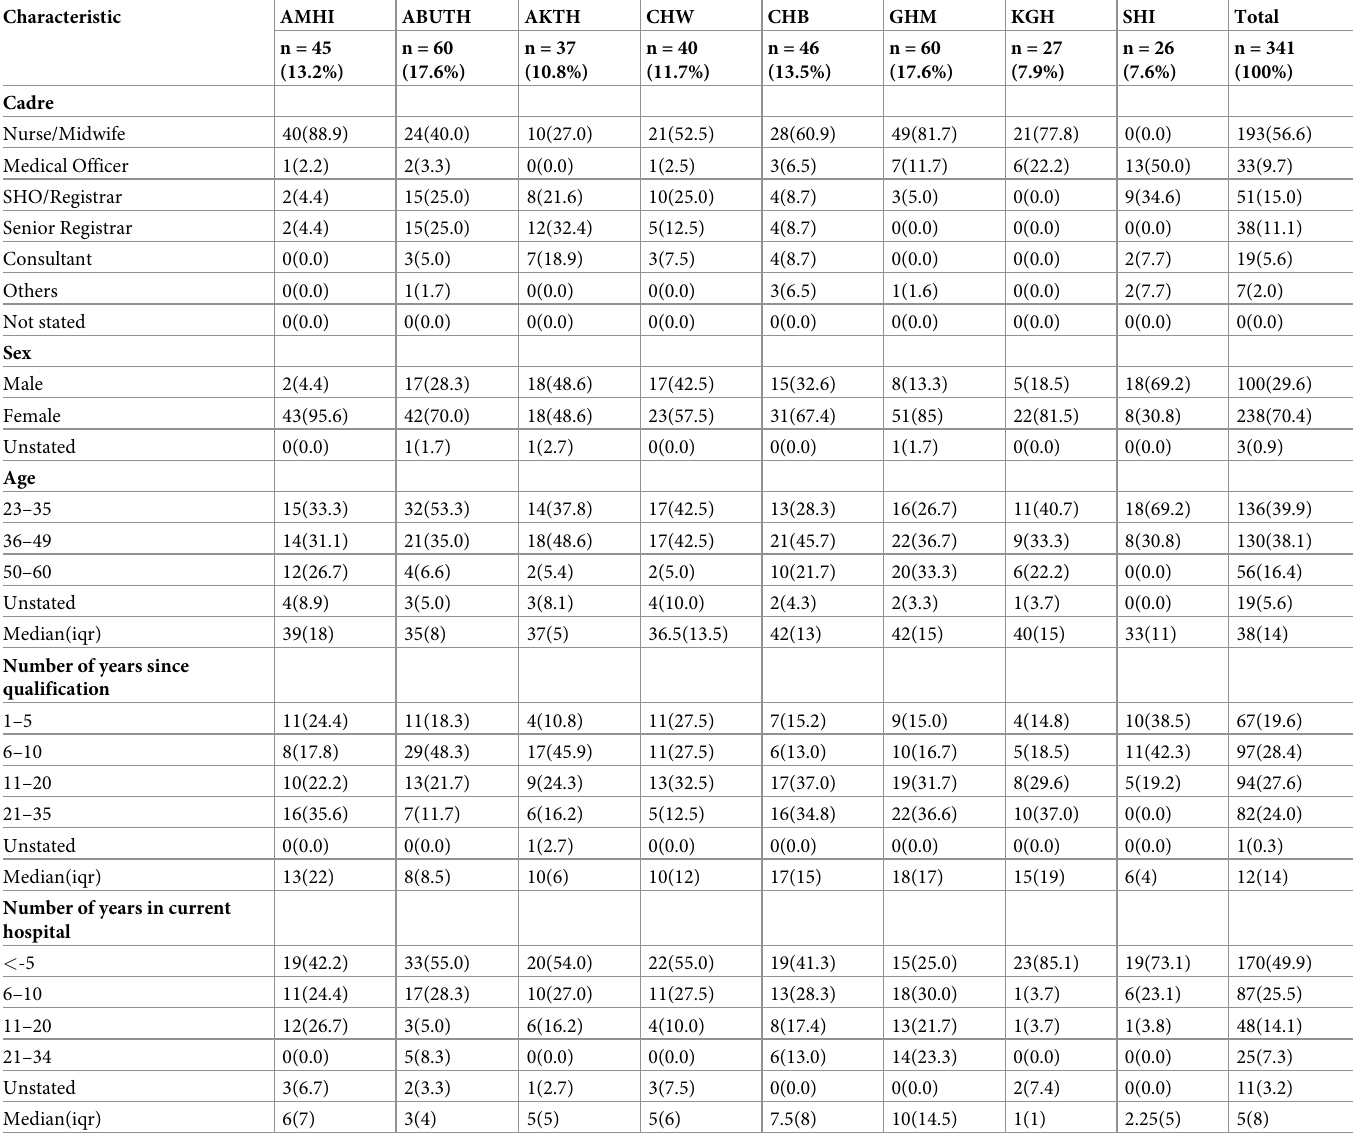
Table 1. Socio-demographic characteristics and number of respondents per